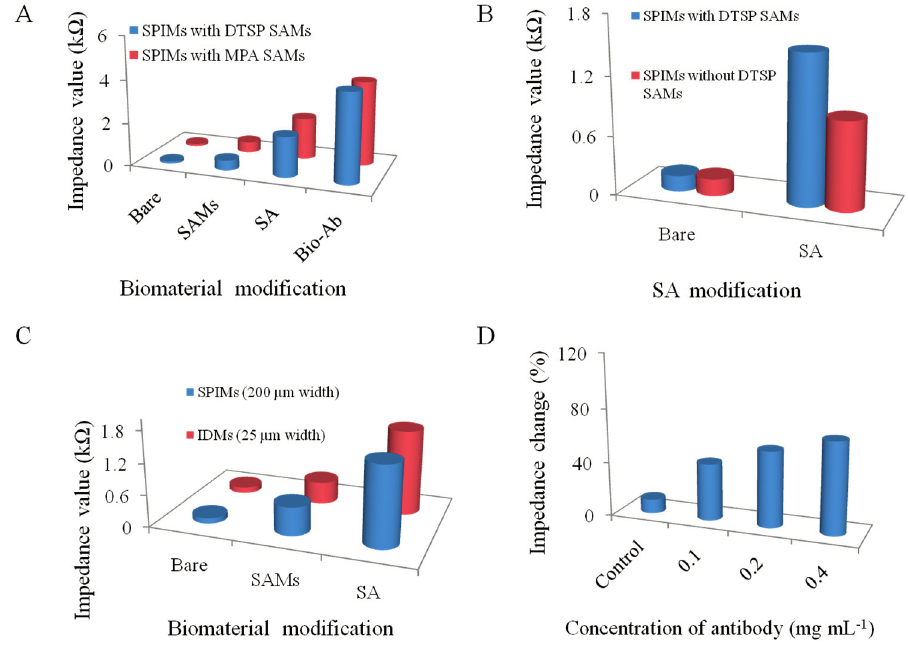
Figure 3. ( A ) The performance of the different SAMs (DTSP SAMs and 3-Mercaptopropionic acid (MPA) SAMs); ( B ) The absorption capacity of SPIMs with or without SAMs; ( C ) Comparison of the SPIMs (200 µm width of electrode fingers) and interdigitated microelectrodes (IDMs, 25 µm width of electrode fingers); and ( D ) The optimization of the antibody concentration. All the experiments were repeated more than three